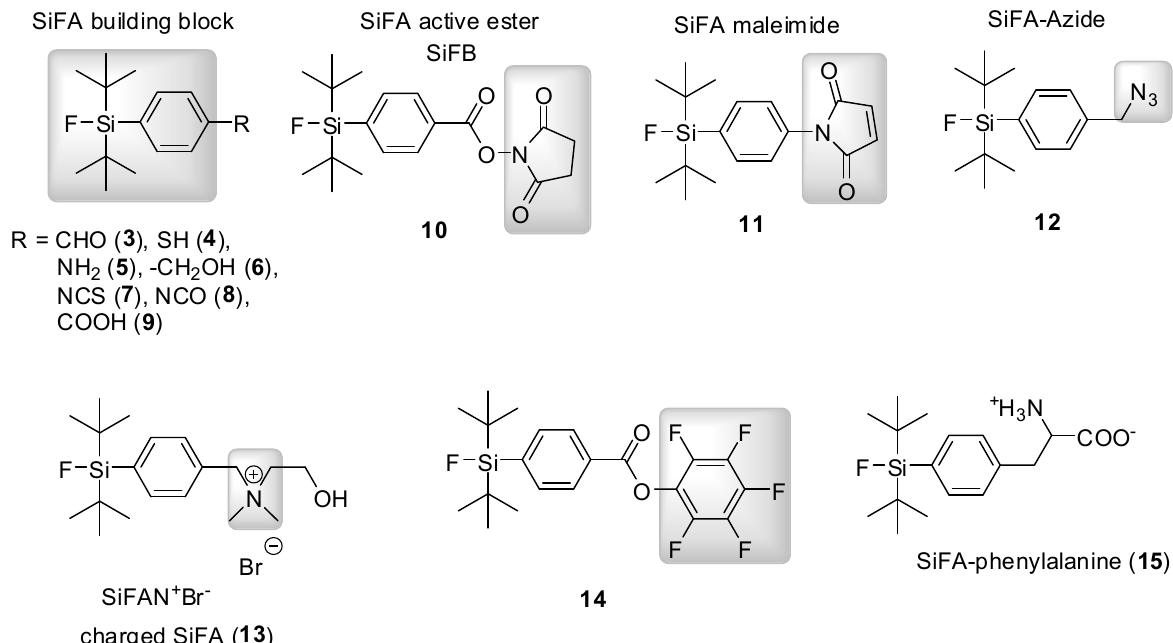
Figure 3. Structures of small molecule SiFA building